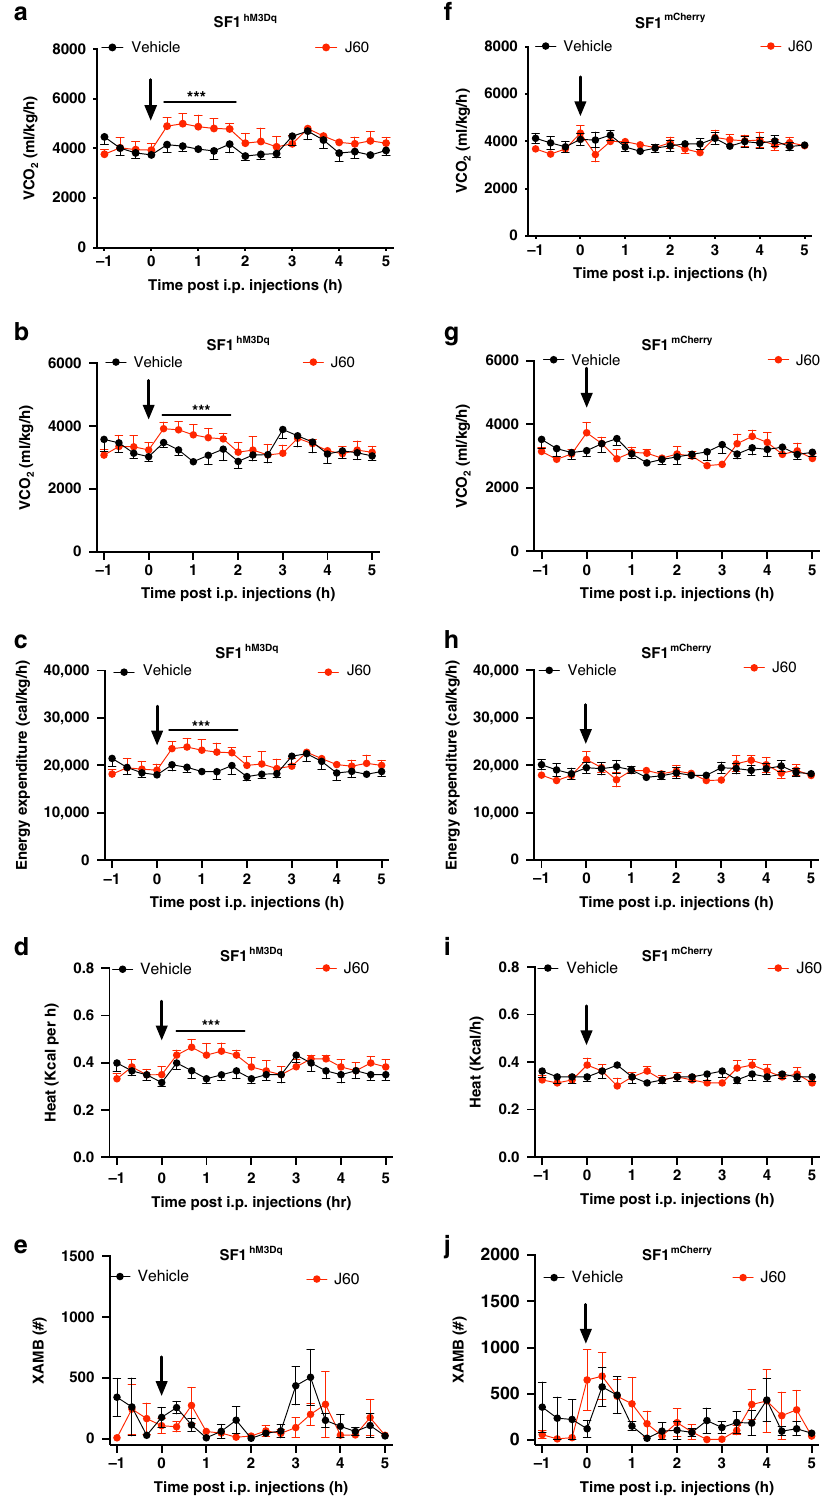
Fig. 10 Activation of SF1 neurons induces energy expenditure. a – e As compared to vehicle treatment, DREADD activation of SF1 neurons with J60 via i.p. injections in the VMH SF1 neuron hM3Dq-transduced mice ( n = 6) increased O 2 consumption ( a p = 0.0003), CO 2 production ( b p = 0.0008), energy expenditure ( c p = 0.0003), and heat production ( d p = 0.0003), while no apparent effect was observed on locomotion ( e ). f – j In the VMH SF1 neuron mCherry-transduced mice ( n = 8), J60 administration via i.p. injections did not elicit alterations on O 2 consumption ( f ), CO 2 production ( g ), energy expenditure ( h ), heat production ( i ), or locomotion ( j ). Two-way ANOVA with Sidak post hoc tests were performed. Data represent mean ± s.e.m. *** p <